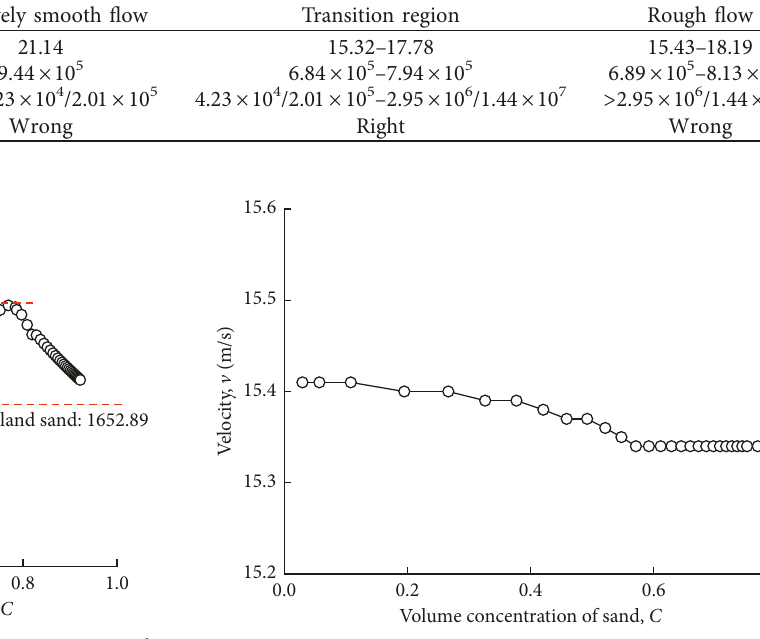
Figure 12: Density of sand-water mixture change curve with volume ratio C .